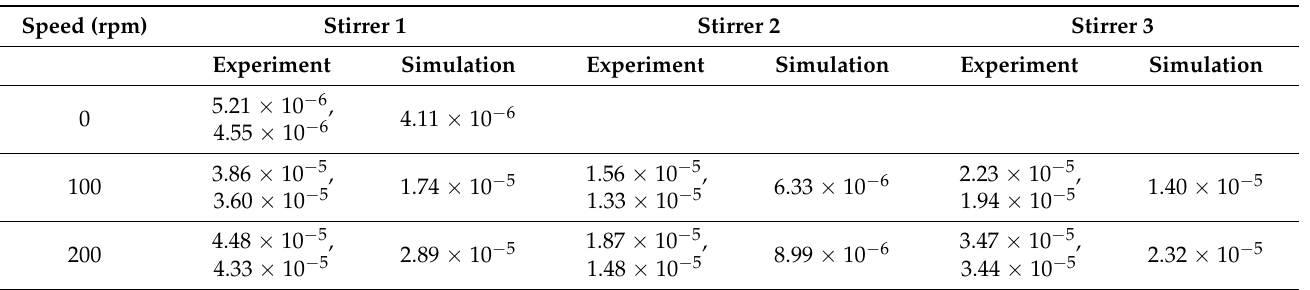
Table 2. Comparison of estimated mass transfer coefficients (m s − 1 ) between experimental and simulation results. The experimental data are taken from Langrish et al. [23]. Speed (rpm) Stirrer 1 Stirrer 2 Stirrer